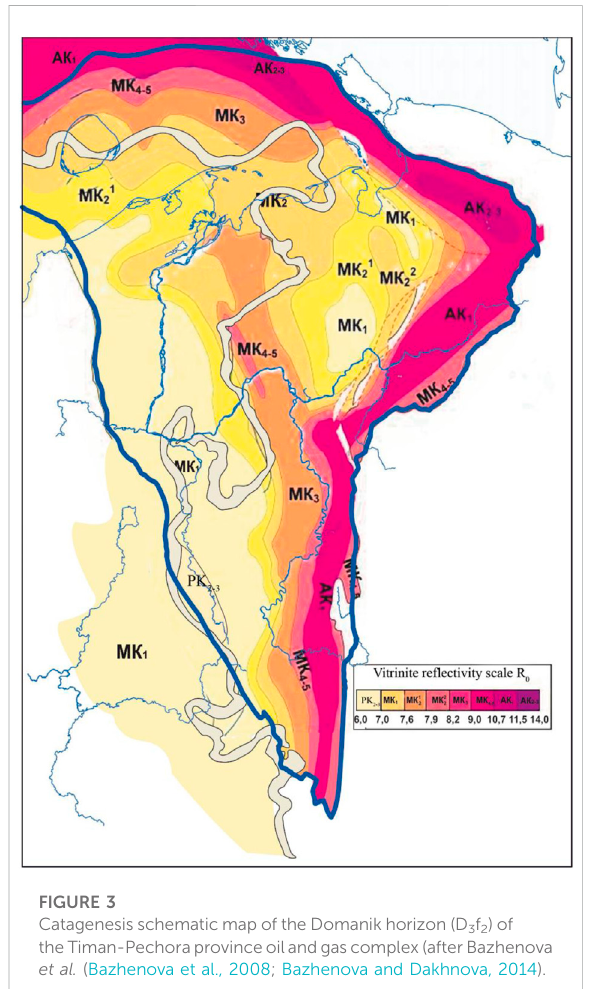
FIGURE 3 Catagenesis schematic map of the Domanik horizon (D 3 f 2 ) of theTiman-Pechoraprovinceoilandgascomplex(afterBazhenova et al. (Bazhenova et al., 2008; Bazhenova and Dakhnova, 2014).